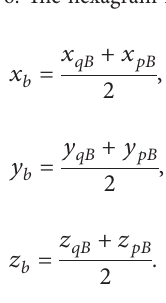
Figure 6: The hexagram